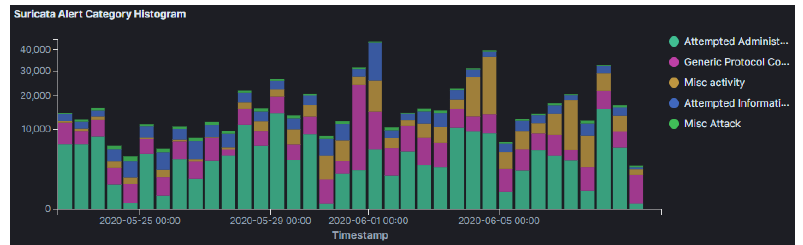
Figure 8. GCP Suricata Alert Category Histogram.